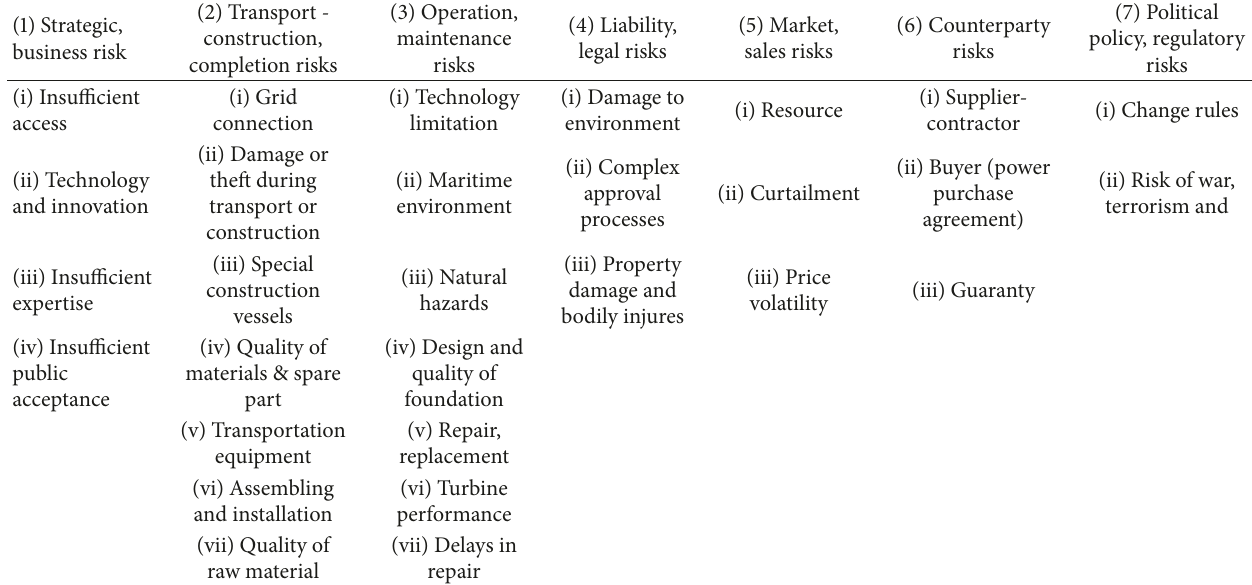
Table 1: Risk classification.